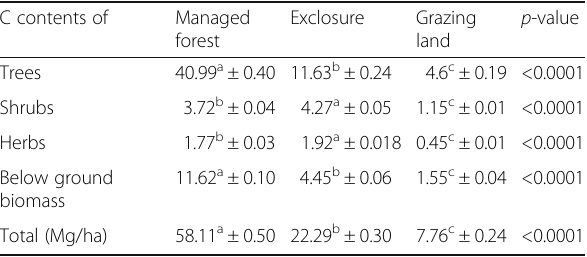
Table 3 Estimated carbon (C) stocks (Mg/ha) in plant biomass across the three management treatments, i.e. community forest, exclosure and communal grazing land